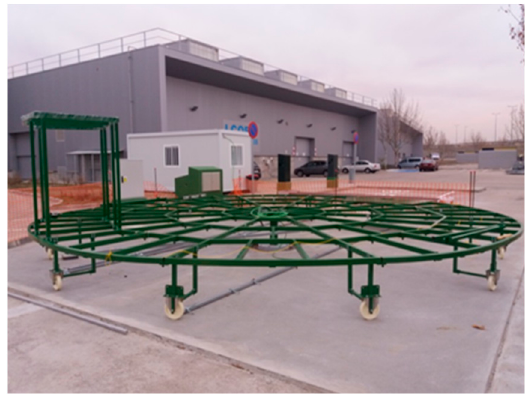
Figure 19. Image of platform base construction with rectangular profile of 60 × 40 mm.